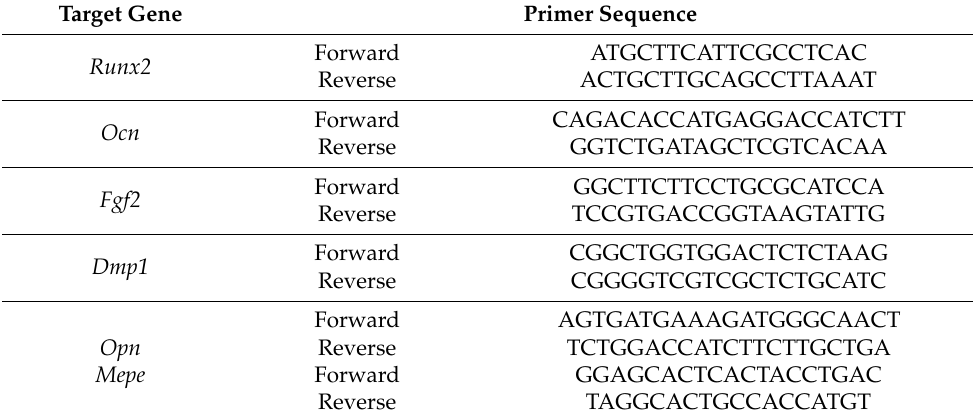
Table 1. Primer sequences used for real-time